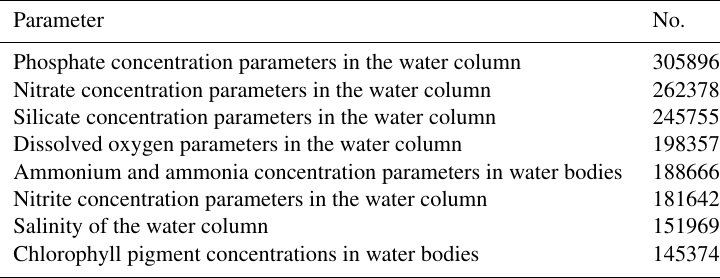
Table 1. Number of stations for the parameters with more data available.